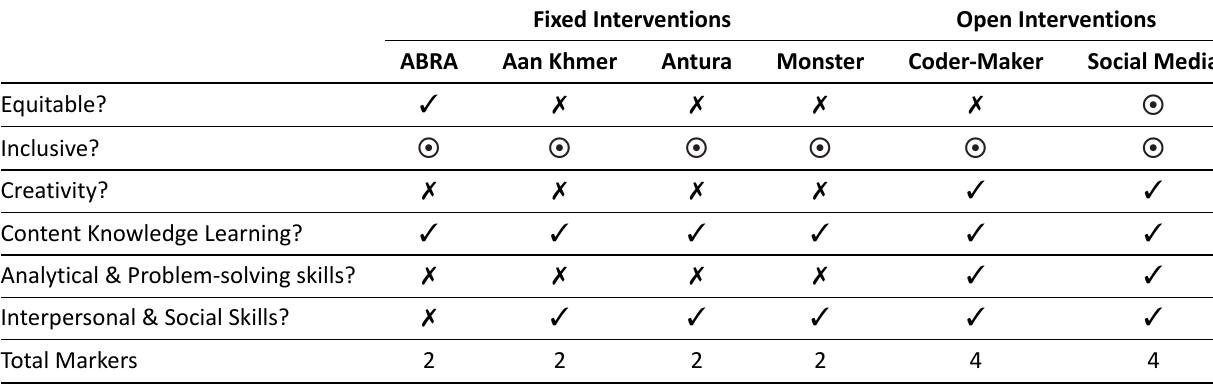
Table 4. Summary of quality markers.